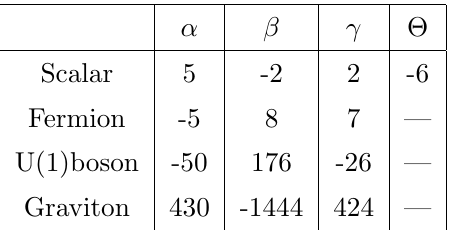
Table 1 . The coe(cid:14)cients appearing in the e(cid:11)ective action due to massless (cid:12)elds of various spins [10]. All numbers are divided by 11520 (cid:25) 2